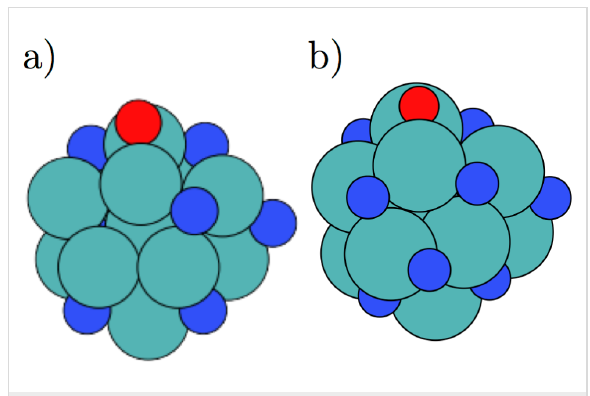
Figure 1: (a) Adsorption of oxygen at a nitrogen vacancy site on Mo 13 N 10 , and (b) adsorption of oxygen at a nitrogen vacancy site on Mo 13 N 12 . Oxygen is adsorbed in the bridge site in both cases.